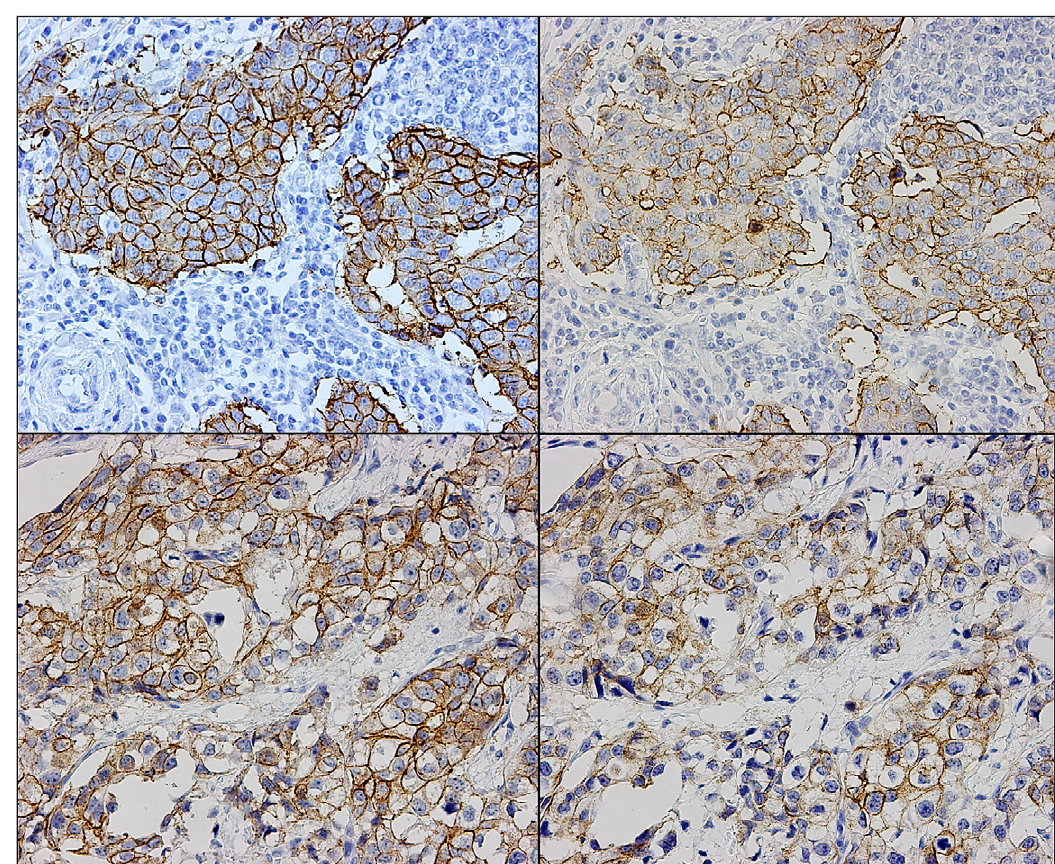
Fig. 2. HER2 immunohistochemistry (IHC) discrepancies between HercepTest and the Oracle HER2 Bond IHC detection system. Top left: tumor with HercepTest 3 + score; top right: same tumor with Oracle HER2 Bond IHC system 2 + score (strong membrane staining but not in 30% of cells); bottom left: tumor with HercepTest 2 + /3 + score; bottom right: same tumor with Oracle HER2 IHC system 1 + score (relatively strong membrane staining but not complete in > 10% of cells). (The colors are visible in the online version of the